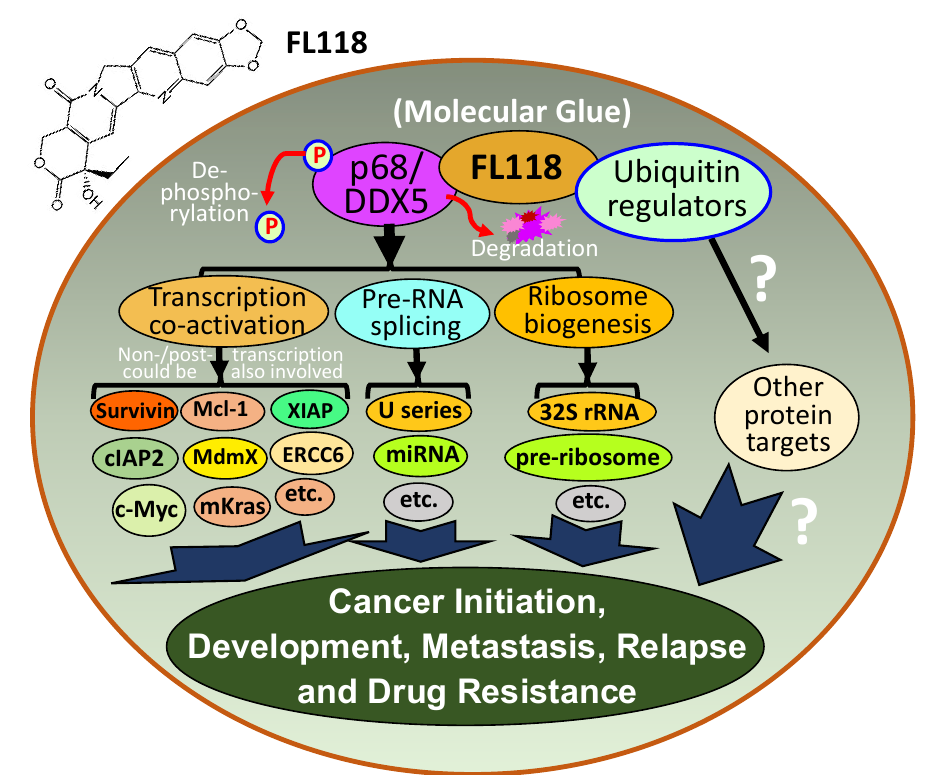
Figure 11. FL118 mechanism of action (MOA). DDX5 is a multifunctional master regulator involved in (1) co-activation of transcription of many oncogenes through the direct interactions of different transcription factors (e.g., c-Myc) in the oncogenic gene promoters, (2) regulation of miRNA and pre-RNA splicing (e.g., U1, U2, U3, … snRNP), and (3) ribosome biogenesis (e.g., 32S rRNA, pre-ribosome). The small-molecule drug FL118 directly binds to and functionally dephosphorylates and degrades DDX5 protein (without decreasing DDX5 mRNA) through the proteasome degradation pathway. This suggests that FL118 could glue both DDX5 and ubiquitin-involved protein stabil- ity/degradation regulators (i.e., FL118 acts as a “molecular glue degrader”). All the DDX5 down- stream protein targets were known to be involved in cancer initiation, development, metastasis, recurrence, and treatment resistance. Therefore, indirectly blocking DDX5 downstream targets through direct dephosphorylation and degradation of DDX5 by FL118 could result in FL118 high antitumor efficacy as demonstrated in our recent study, which used human CRC and PDAC cell and tumor models [49].